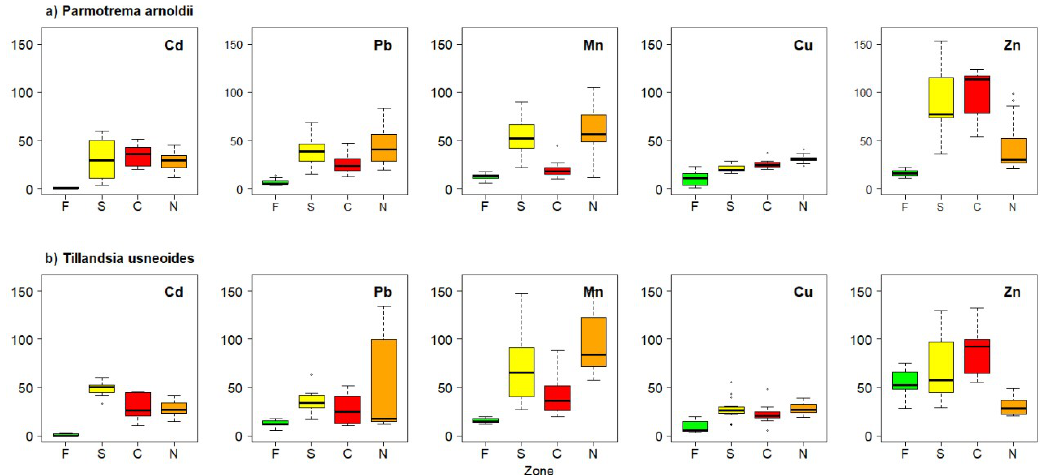
Figure 2. Boxplots depicting heavy metal (Cd, Pb, Mn, Cu and Zn) concentrations in ( a ) Parmotrema arnoldii, and ( b ) Tillandsia usneoides in Loja. Colours correspond to zones: Yellow = South, orange = North, red = Center, green = Forest.